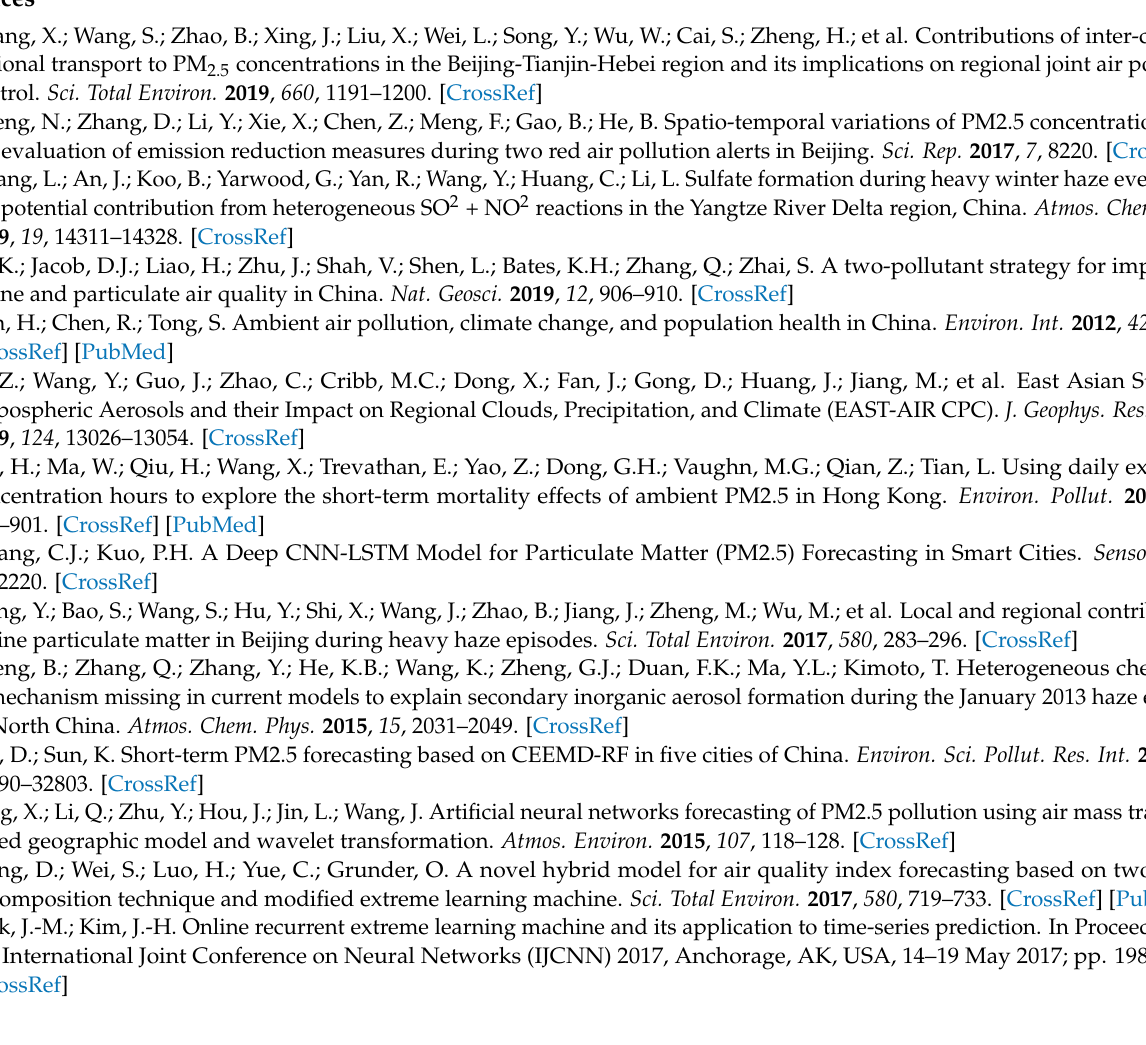
Figure S2: Diurnal variation of the average concentrations of observed PM 2.5 in the whole YRD(a) region, and Shanghai(b), Nanjing(c), Hangzhou(d), Heifei(e) and Xuzhou(f), respectively. Figure S3: Prediction of OS-ELM, OR-ELM and OR-ELM-AR with different lead times. All authors have read and agreed to the published version of the